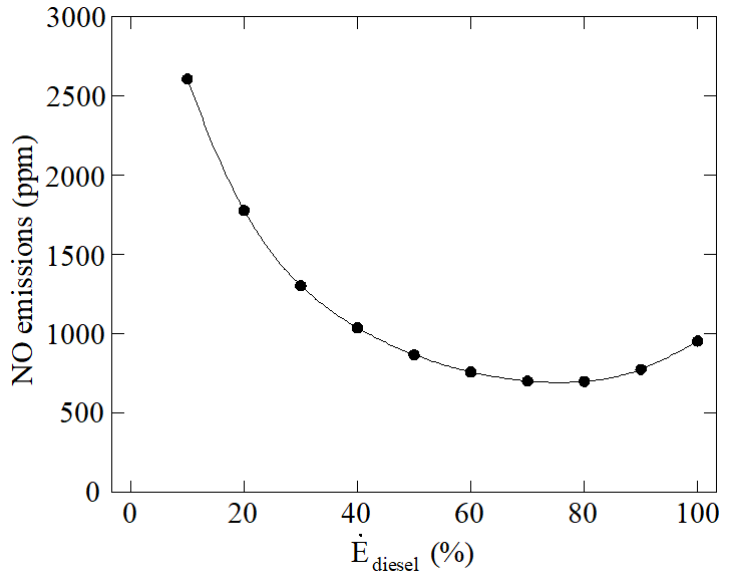
Figure 4. NO emissions against the power contribution from diesel fuel.